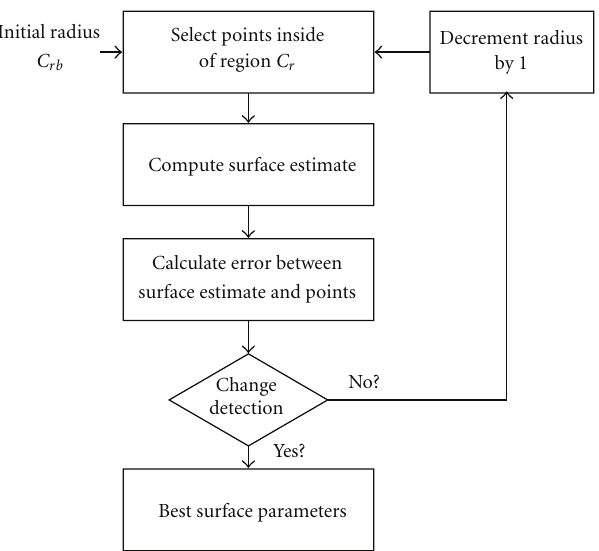
Figure 10: Overview of pleural point subset selection and surface parameter estimation.